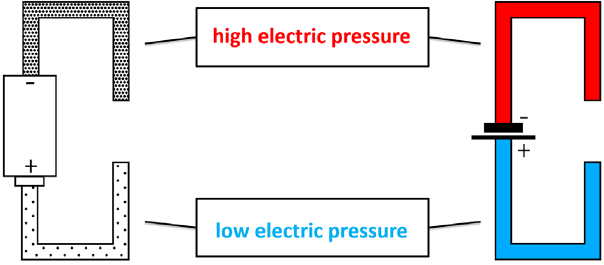
FIG. 4. The initial juxtaposition of the familiar particle model with color coding in an open circuit is intended to facilitate the students ’ transition from the idea of air pressure in pipes to electric pressure in